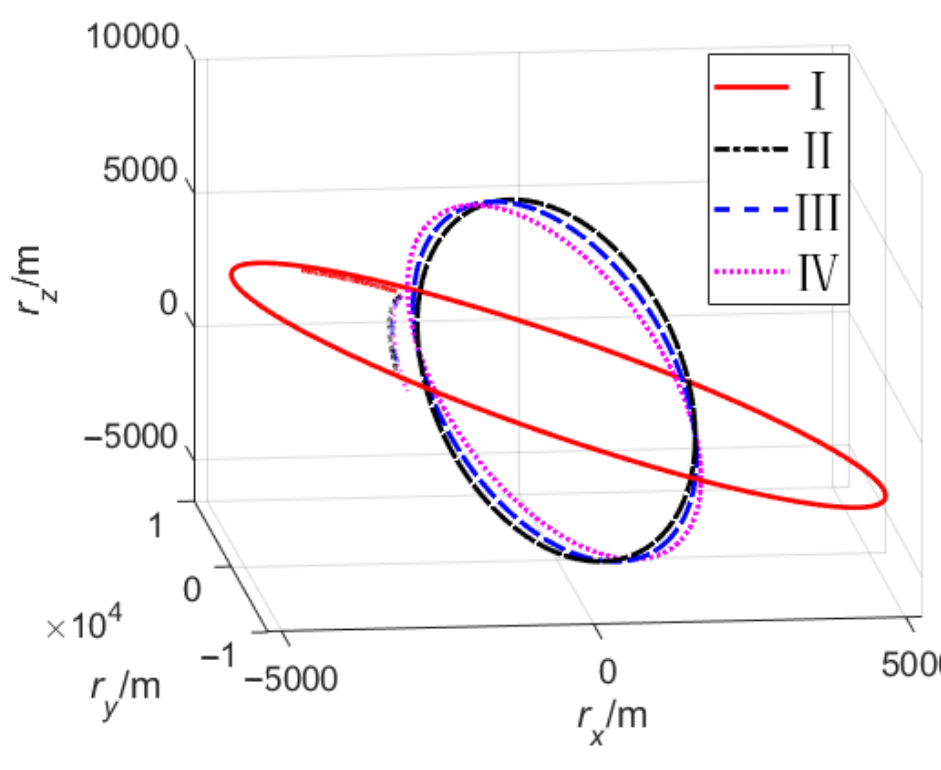
Figure 7. Engine thrust.